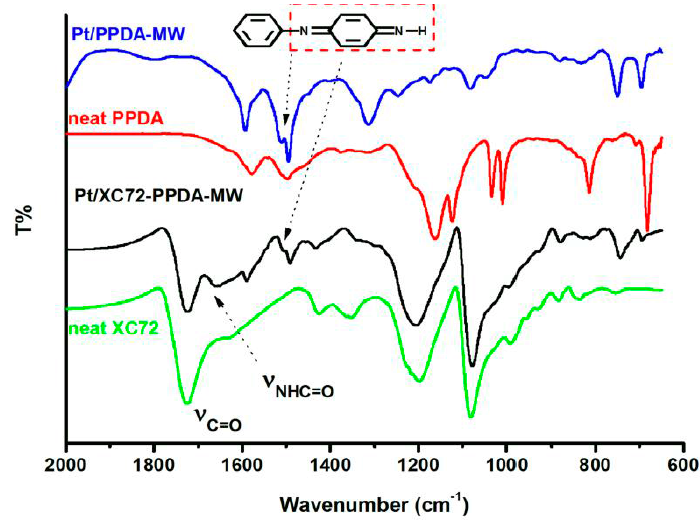
Figure 2. FTIR spectra of neat PPDA and Pt/XC72-PPDA-MW.